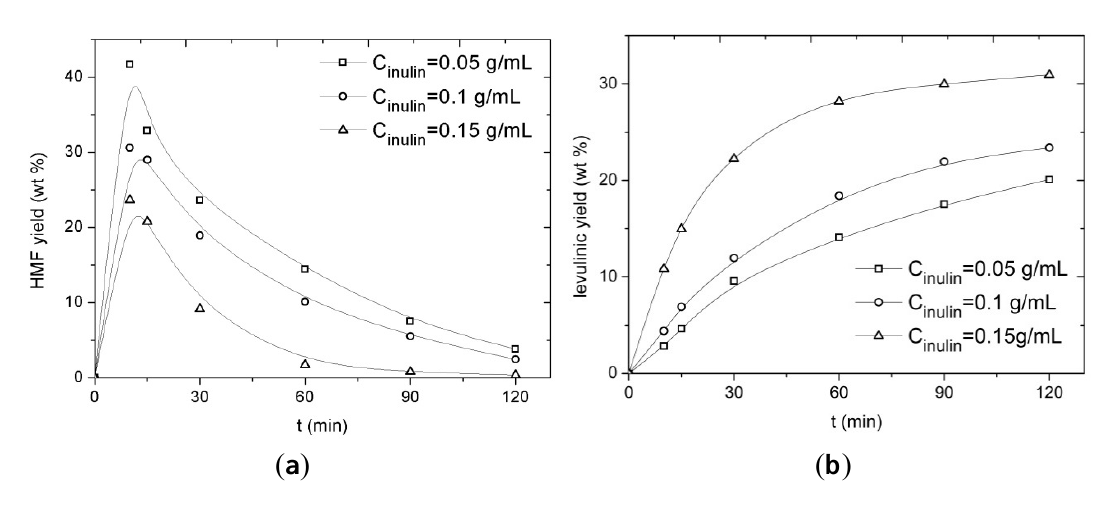
Figure 8. ( a ) HMF and ( b ) LA yield versus the time at various inulin intakes ( T = 180 °C, C CuCl2 = 0.01 M).